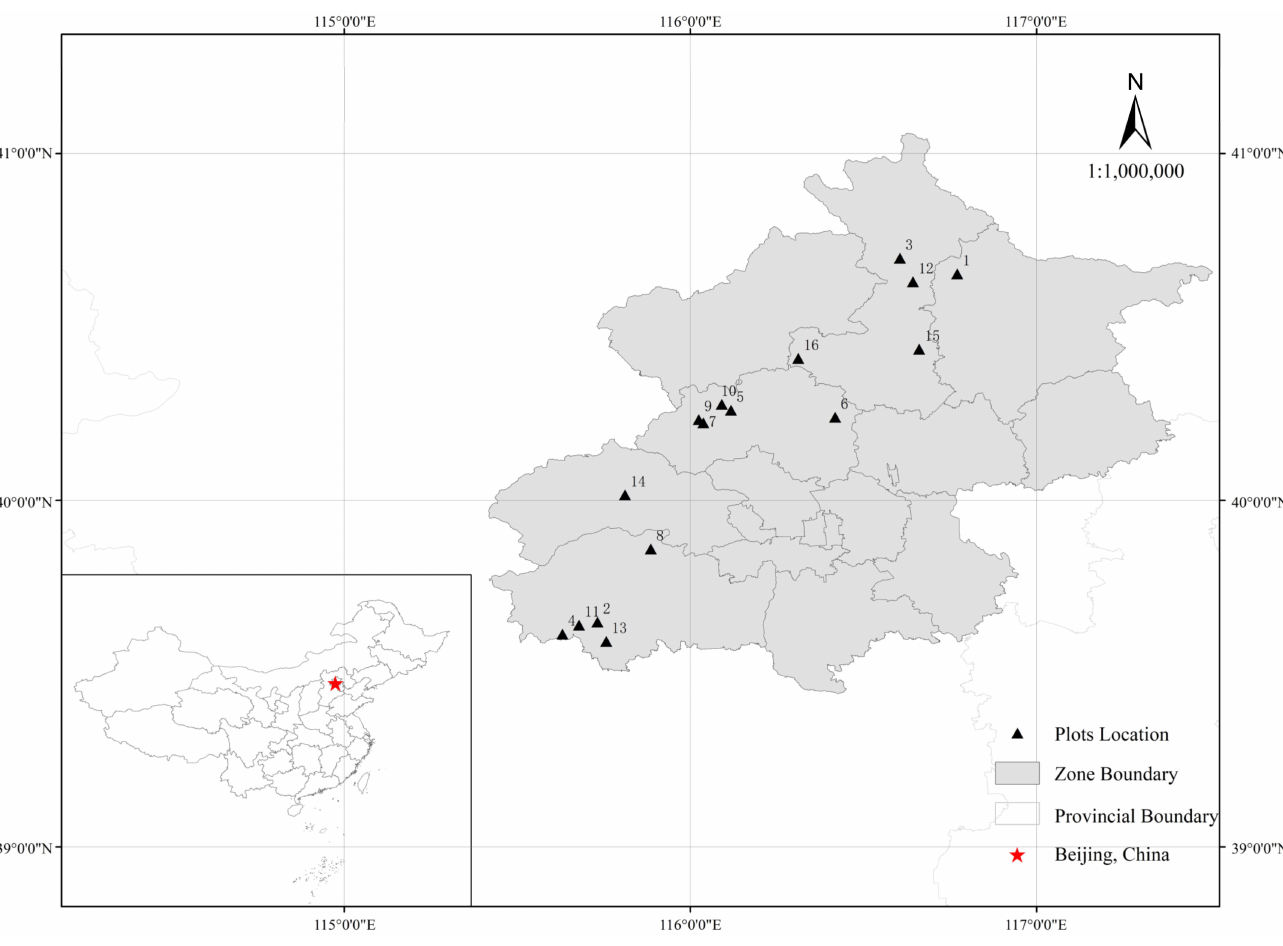
Figure 1. Overview of the study